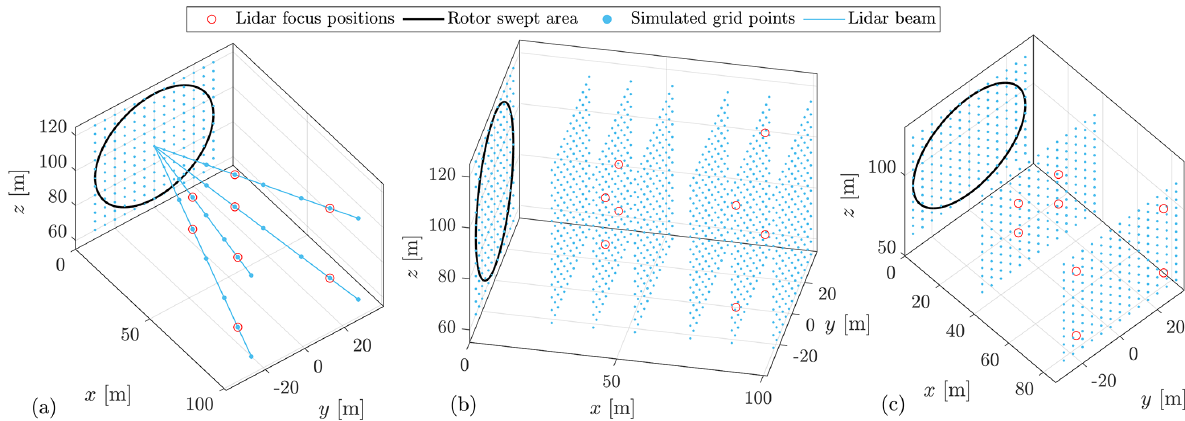
Figure 10. Illustration of three types of grids for lidar simulations. (a) Direct grid. (b) Full grid. (c) Semi-frozen grid.